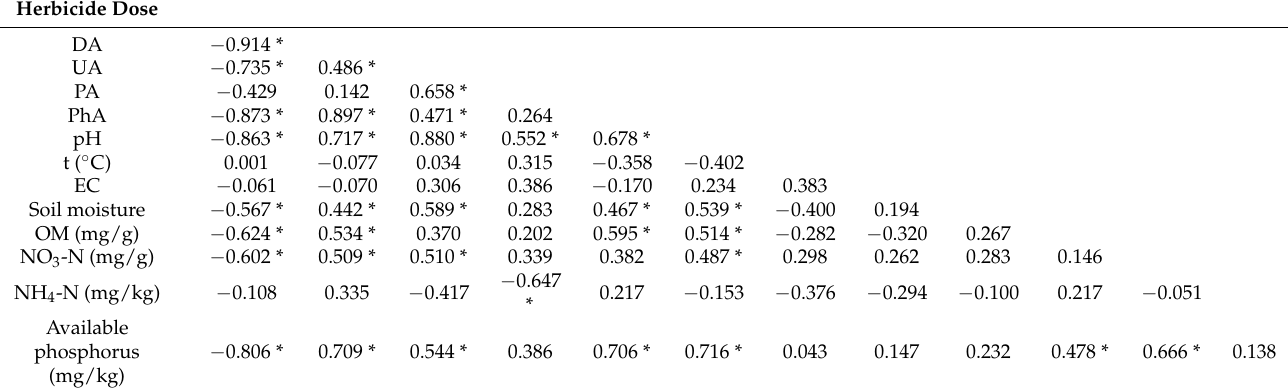
Table 3. Correlations between the enzymatic activities, the herbicide dose and the soil physicochemical parameters: DA- dehydrogenase activity, UA—urease activity, PA—protease activity, PhA—phosphatase activity, EC—electric conductivity, OM—organic matter content.